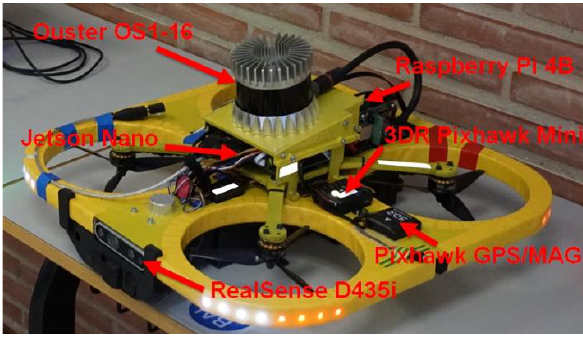
Figure 2. The components on the MAX drone used for positioning and